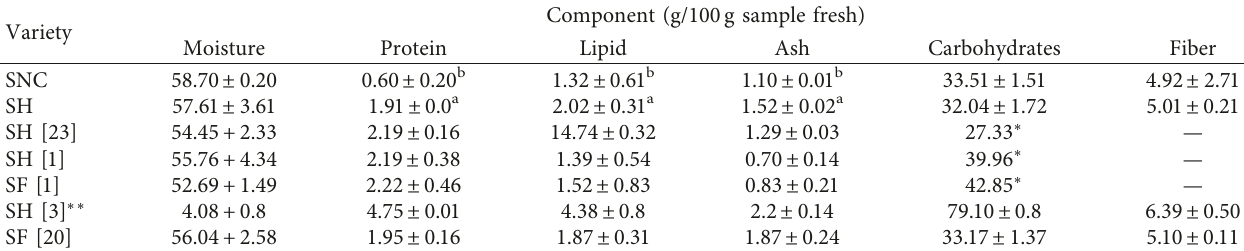
Table 1: Nutritional composition of SH and SNC versus bibliographic values [1, 3, 20, 23].